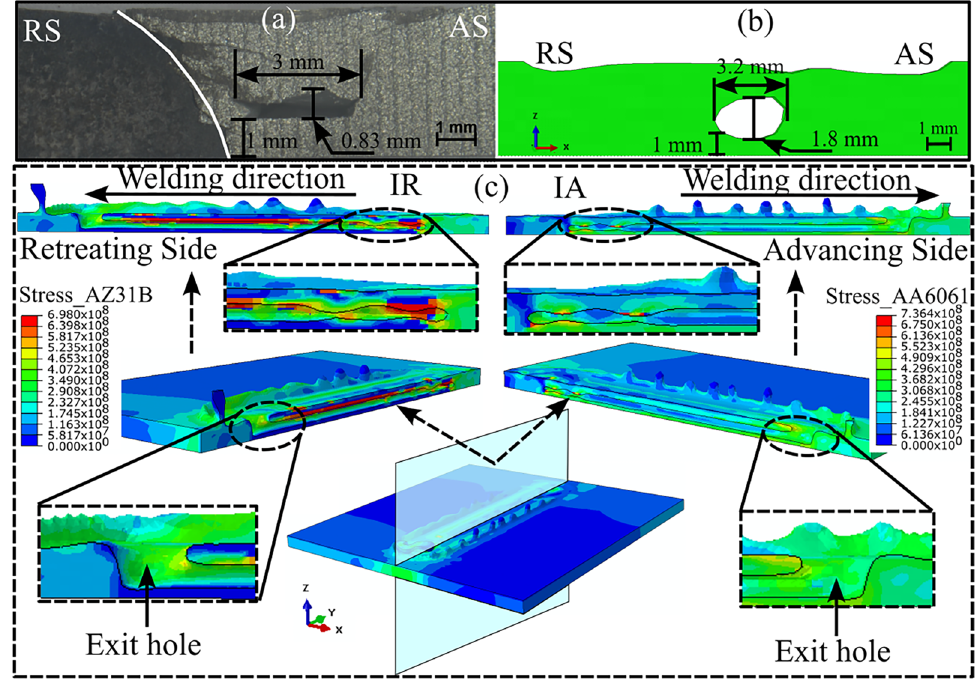
Figure 9. An illustration of the cross-sectional subsurface tunnel defect: ( a ) experimentally and ( b ) numerically modeled results; ( c ) the progress of the subsurface tunnel defect and stress distribution within the workpiece.